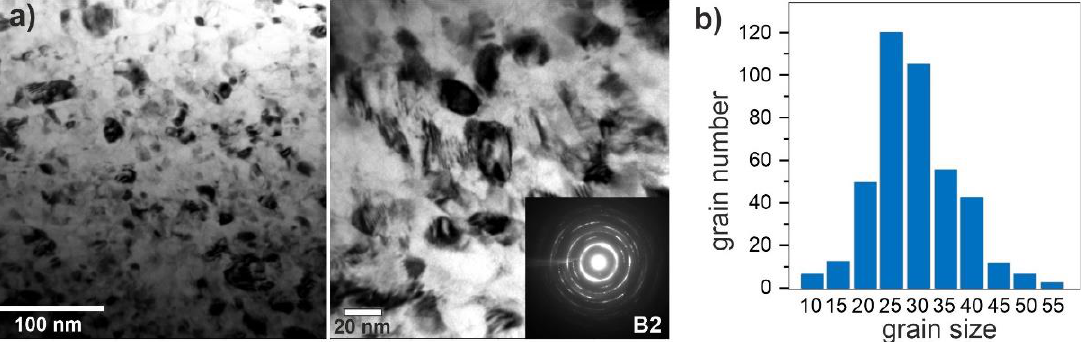
Figure 5. Bright field TEM image with corresponding diffraction pattern ( a ) and grain size distribution histogram ( b ) for a 60 µm diameter TiNi wire.